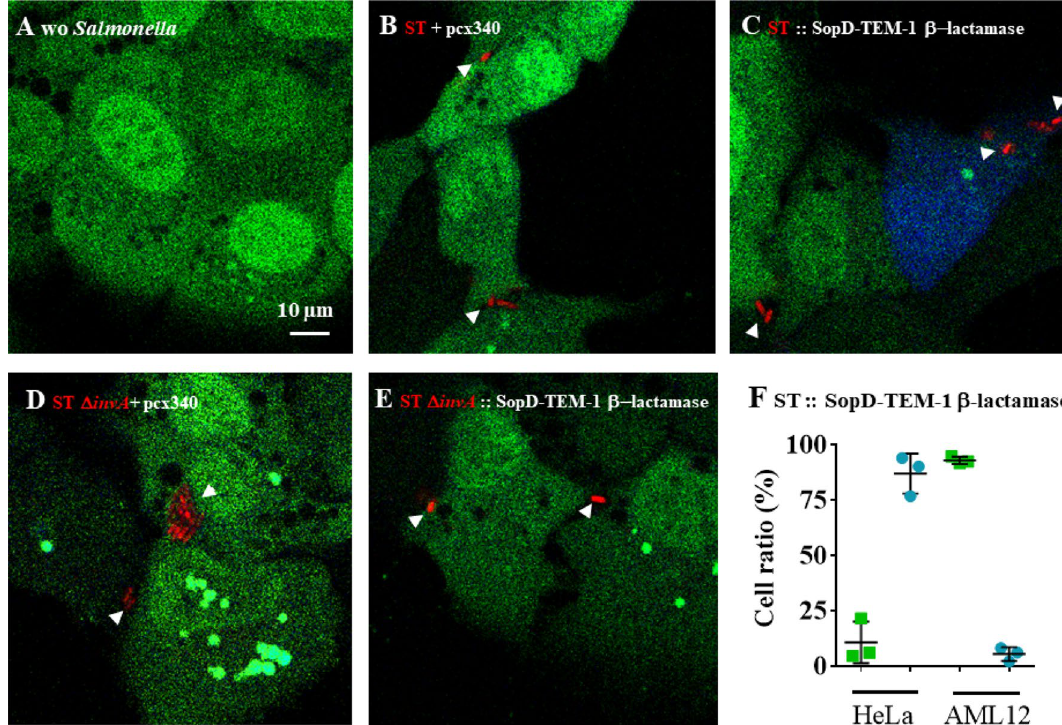
Figure 4. T3SS1 effector translocation occurred only in very few infected AML12 cells. AML12 cells were exposed for 30 min to ST or ST Δ invA strains expressing SopD effector-TEM-1 β-lactamase in pCX340 and DsRed in pGG2, then washed and infection was continued for 60 min. Subsequently, cells were loaded with CCF4-AM for 20 min and visually inspected ( A – E ) using an inverted confocal microscope equipped with a 100 × oil immersion objective (LEICA TCS SP8, Germany). Images of 1024 × 1024 pixels were acquired using LaserX software (LEICA). Green fluorescence indicates that CCF4-AM was loaded and the presence of blue cells due to CCF4-AM cleavage reveals SopD translocation. White arrowheads indicate Salmonella . ( A ) non-infected AML12 cells, ( B ) cells infected with the ST DsRed strain carrying the empty vector pCX340, ( C ) cells infected with the ST DsRed strain expressing SopD effector-TEM-1 β-lactamase in pCX340, ( D ) cells infected with the ST Δ invA DsRed strain carrying the empty vector pCX340 and ( E ) cells infected with the ST Δ invA DsRed strain expressing SopD effector-TEM-1 β-lactamase. The cells emitting blue fluorescence were considered as positive for effector translocation. ( F ) HeLa and AML12 cells were infected as described above with the ST strain expressing SopD effector-TEM-1 β-lactamase and DsRed, CCF4-AM loaded and finally trypsinized. Cell resuspensions were acquired using cytometry (BD LSRFortessa X-20 cell analyzer) and analyzed by BD FACSDiva Software. Green squares represent cells infected without SopD translocation; Blue dots represent infected cells with SopD translocation. Scale bars 10